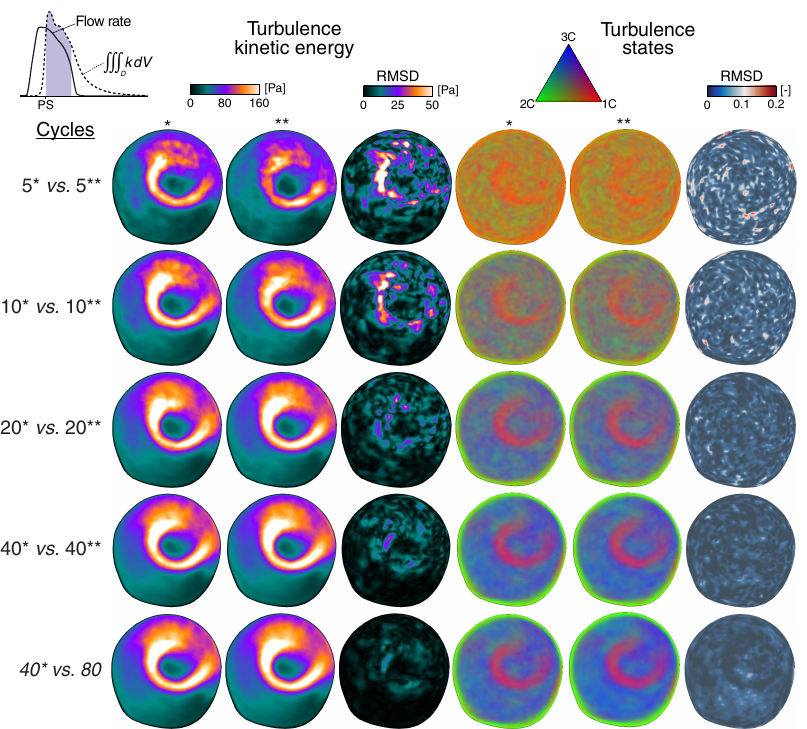
Figure 6. Phase-averaging effects on the time-averaged Reynolds stress characteristics at one stenotic diameter (1D) downstream of the constriction. The mean RMSD errors over all cross-sections are given in Figure 3 (EFD, gray and red bars). For additional details see Figures 2–5.